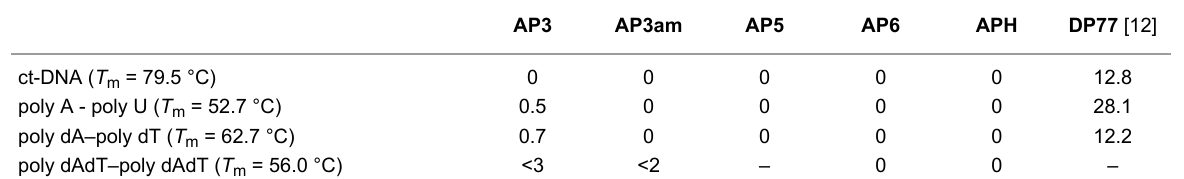
Table 1: The Δ T ma values (°C) of studied ds-polynucleotides upon addition of AP3 , AP3am AP5, AP6 and APH at pH 7.0 (sodium cacodylate buffer, I = 0.05 mol dm − 3 ), ratio r = 0.3 b . AP3 AP3am AP5 AP6 APH DP77 [12] ct-DNA ( T m = 79.5 °C)